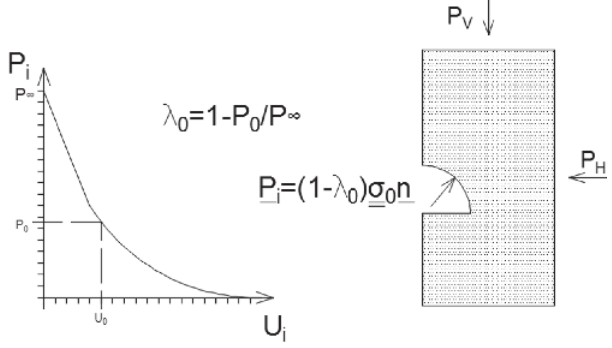
Figure 4 sums up how the NIM method works integrating the two charts which correlate the convergence, the pres- sure and the location of the studied section by setting the lining supported function and getting the value for U respective pressure.